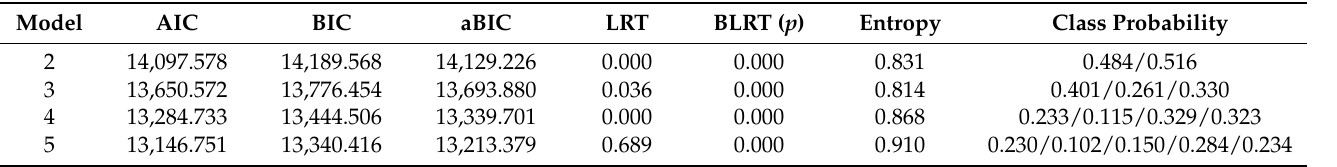
Table 4. Latent profile analysis model-fit statistics of the potential